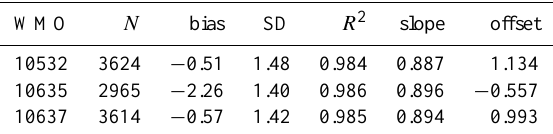
Table 3. Scatter plot properties for the different IWV measure- ments, calculated for the IGS station FFMJ with surface observa- tions from different WMO SYNOP stations on one hand, and the co-located CIMEL sun photometer on the other hand. WMO N